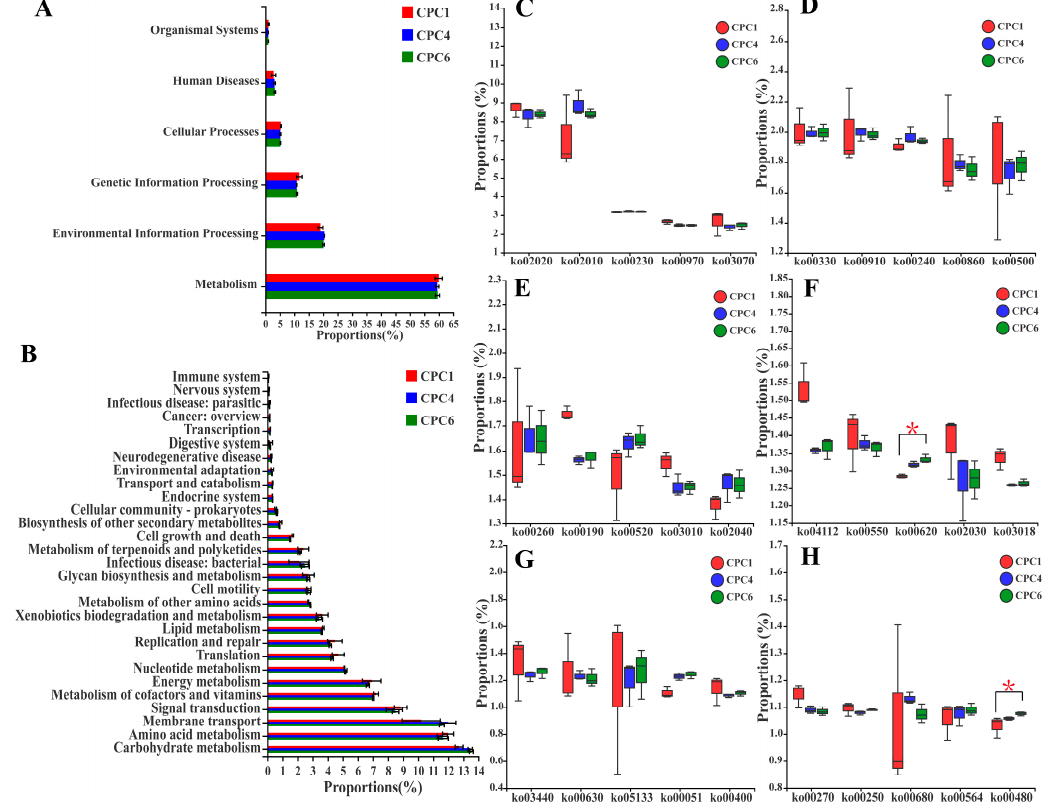
Figure 12. Functional prediction of the intestinal microbiota of grass carp fed with different protein level diets based on Tax4 Fun. ( A ) Functional prediction of the different treatment groups at Level 1. ( B ) Functional prediction of the different treatment groups at Level (top 30 relative abundances). ( C – H ) Differences in KEGG pathway abundance in the different treatment groups at Level 3 (top 30 relative abundances). Kruskal–Wallis rank-sum test was used for significance test ( n = 3); * 0.01< p ≤ 0.05.